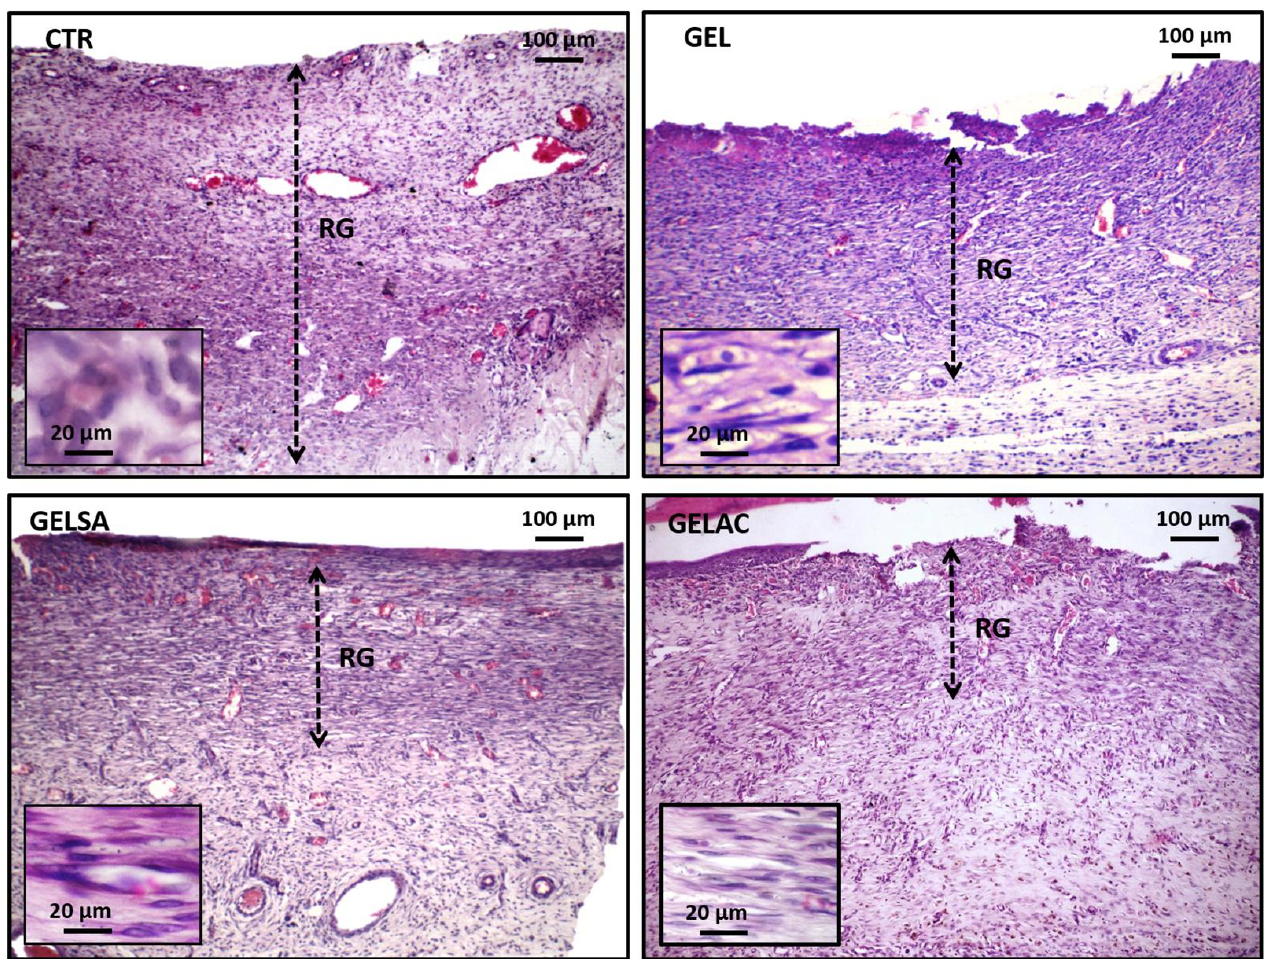
Figure 12. Photomicrographs of HE-stained histological sections representative of the 7-day repair process. All groups present exuberant granulation reactions occupying the repair area. CTR exhibits a granulation reaction band that extends from the hypodermis to the wound surface (“top to bottom”), whereas in GEL, it occupies approximately 2/3 superficial depth of the injured area (100 × ). In GELSA and GELAC, the granulation reaction range occupies approximately 1/3 of the depth extension of the injured area (100 × ). Highlighted detail of the cells of the granulation reaction, consisting of fusiform and inflammatory cells in CTR and GEL, but essentially fusocellular in GELSA and GELAC (400 × ). Caption: CTR—control group; GEL—group treated with gelatin biomembranes only; GELSA—group treated with gelatin biomembranes containing S. adstringens extract; GELAC—group treated with A. cochliacarpa extract; GR—granulation reaction; dotted arrow—thickness, in depth, of the granulation reaction